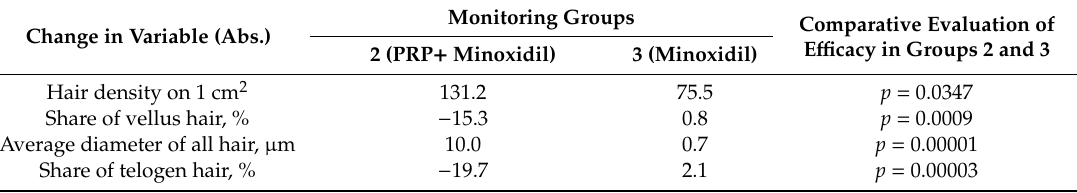
Table 4. Comparison of the e ff ectiveness of treatment in observation groups 2 and 3. Change in Variable (Abs.)